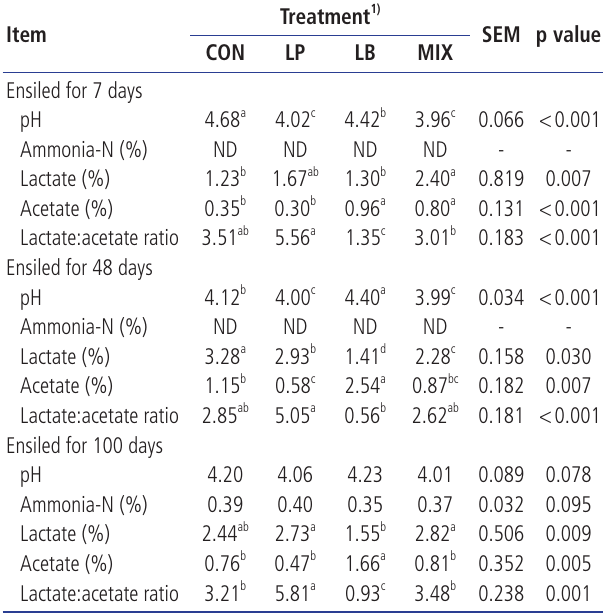
Table 2. Effects of homo and hetero fermentative inoculants on fermentation indices of sweet potato vine mixed with Italian ryegrass hay ensiled for 7,